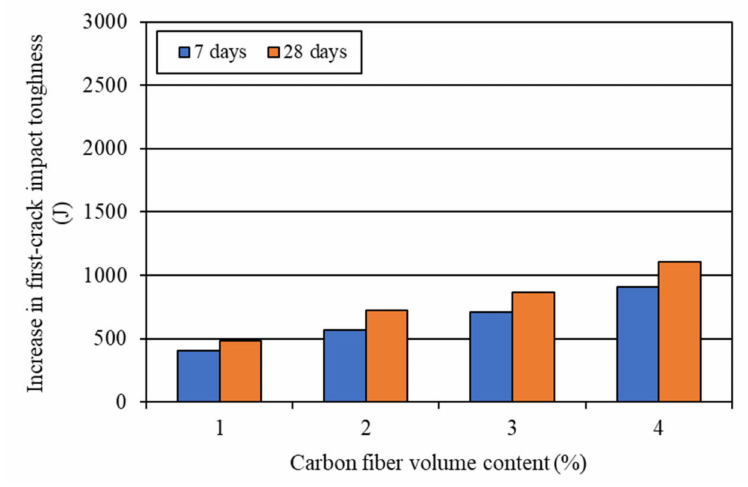
Figure 12. Increase in first-crack impact toughness due to the incorporation of carbon fibers.